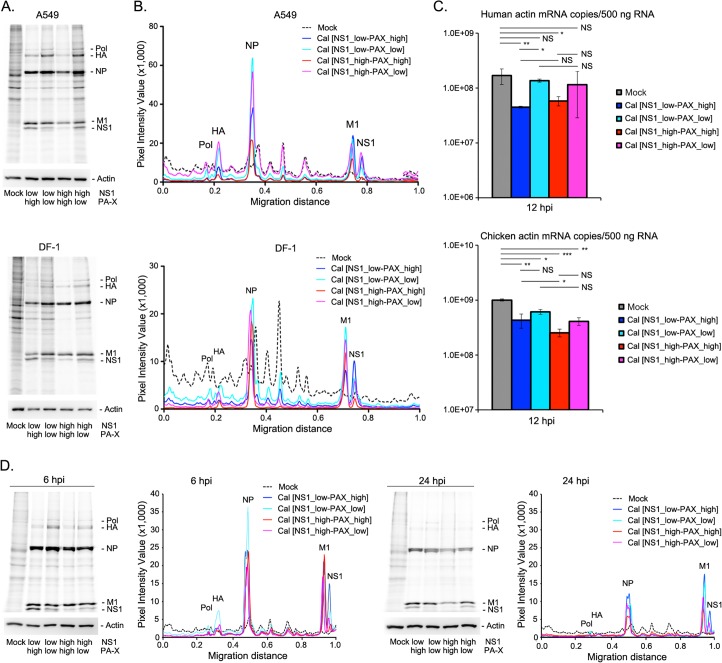
Shutoff activity on host protein synthesis of human and avian cultured cells by mutant viruses.(A) A549 or DF-1 cells were left uninfected or infected with the viruses at MOI of 2. At 16 h pi, cells were labeled with 35S-Met/Cys for 30 min and the radiolabeled lysates were resolved by SDS-PAGE. As loading controls, cellular actin was detected by Western blot analysis (lower panel). (B) Densitometric traces of labeled proteins shown in (A). (C) Quantities of cellular β-actin mRNAs in infected A549 or DF-1 cells at 12 h pi as determined by qRT-PCR. The data represent averages with standard deviations (n = 3). *, P< 0.05, **, P<0.01, ***, P<0.001, NS, not significant. (D) Shutoff activity of the viruses in A549 cells at an early and late time points. Cells were labeled with 35S-Met/Cys at 6 or 24 h pi and total lysates were analyzed by SDS-PAGE as (A).